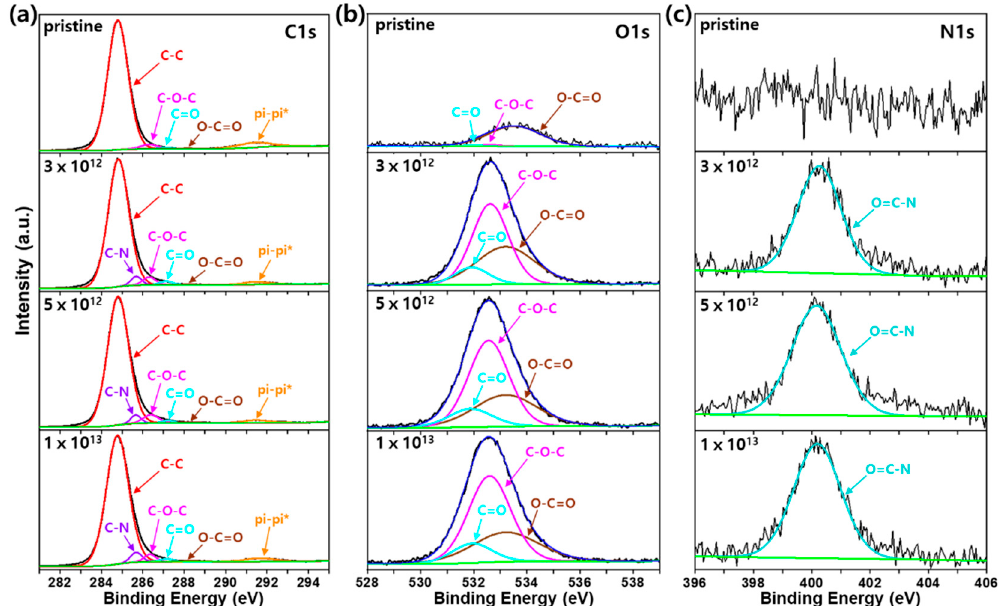
Figure 5. XPS deconvolution spectra of ( a ) C1s, ( b ) O1s, and ( c ) N1s for irradiated PS at various fluences.